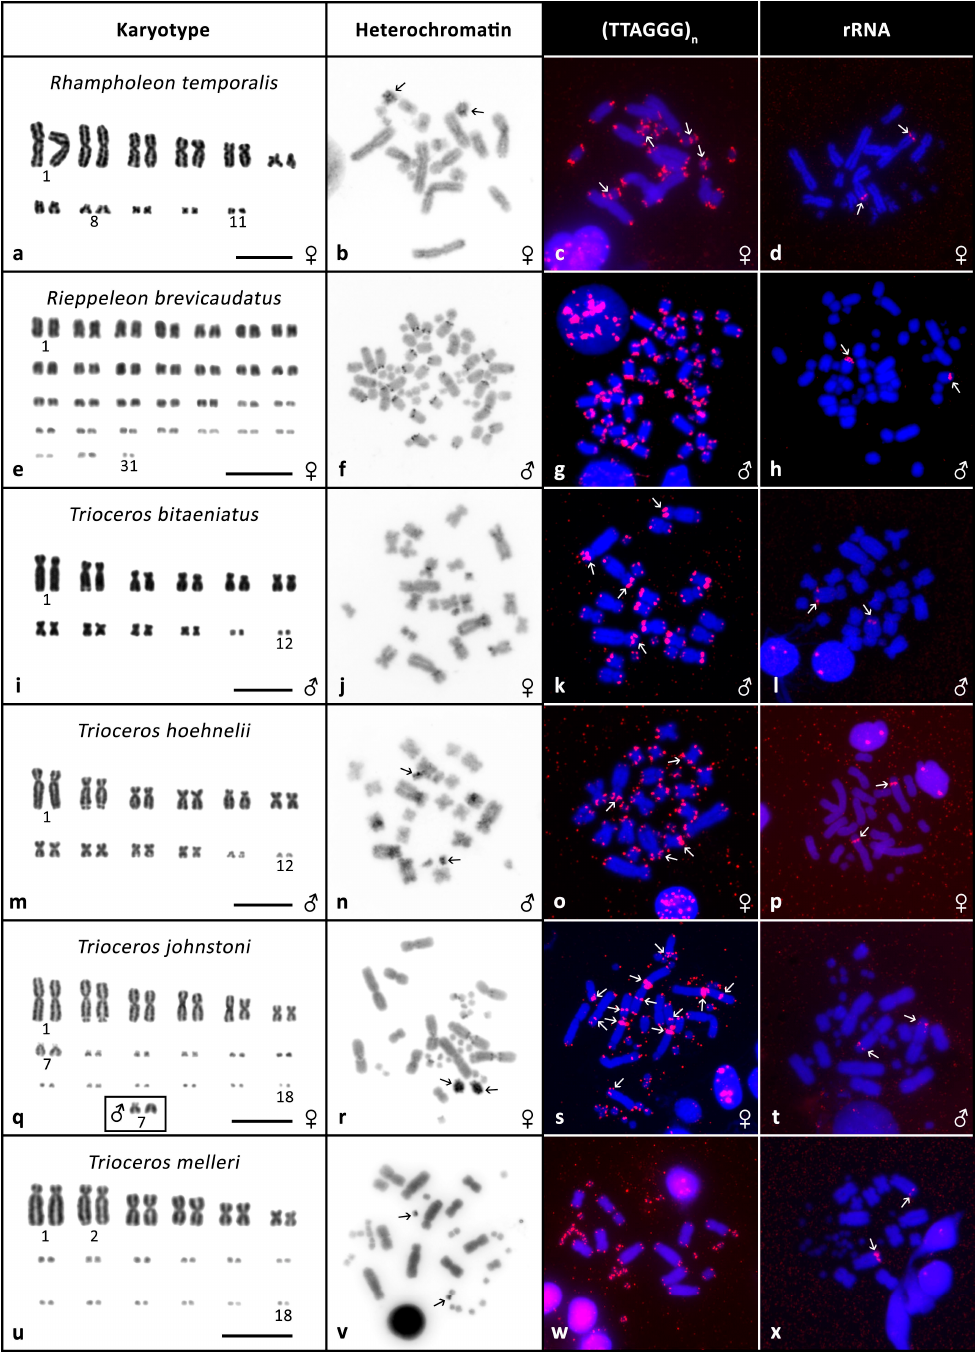
Figure 3. Cytogenetic data. Giemsa stained karyotypes ( a , e , i , m , q , u ), C-banding ( b , f , j , n , r , v ), FISH with telomeric probe ( c , g , k , o , s , w ) and FISH with rRNA probe ( d , h , l , p , t , x ) in Rhampholeon temporalis , Rieppeleon brevicaudatus , Trioceros bitaeniatus , Trioceros hoehnelii , Trioceros johnstoni , Trioceros melleri . Arrows indicate signals.